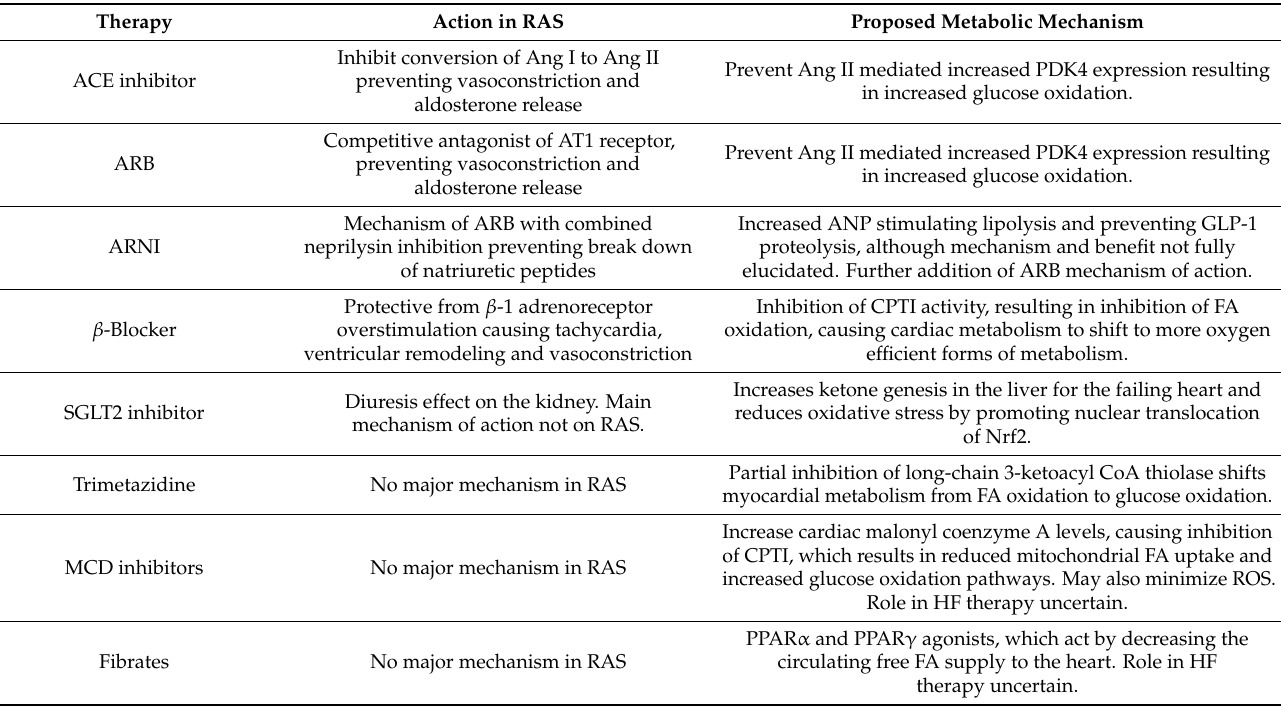
Table 1. Heart failure therapies and mechanism of